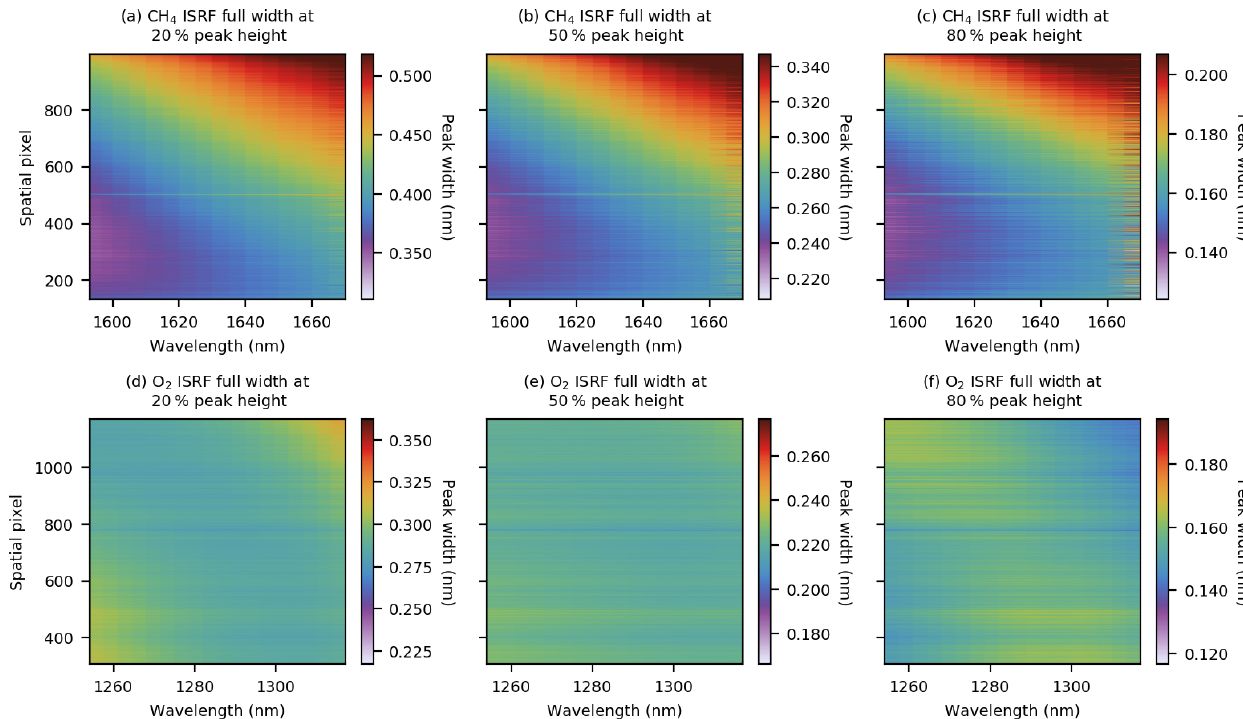
Figure 14. Full width of the smoothed ISRF at 20% (a, d) , 50% (b, e) , and 80% (c, f) of maximum peak height for all spatial and spectral pixels. Gouraud shading is applied to render smooth ISRF variation across the FPA. Wavelength labels have been projected to the abscissa in order to provide more context compared to the spectral pixel index. The top three panels correspond to the CH 4 band, which shows a general broadening of the ISRF with increasing wavelength and spatial pixel index. In contrast, the O 2 band ISRF is more homogeneous across different spatial and spectral pixels, as reinforced by the relatively narrower scales for the bottom three panels. The color limit in each panel is fixed at ± 25% from the FPA-mean value.